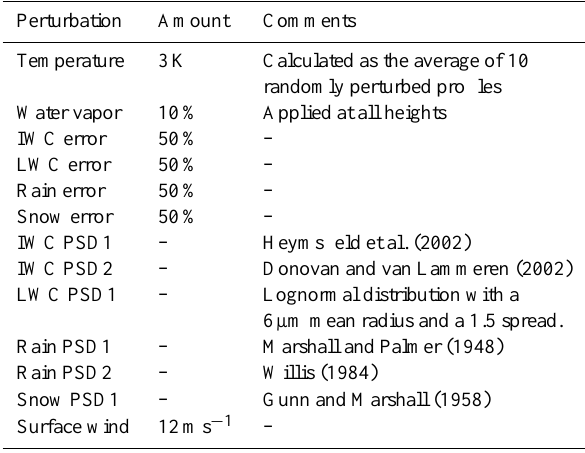
Table 1. Systematic uncertainties perturbations ∗ .